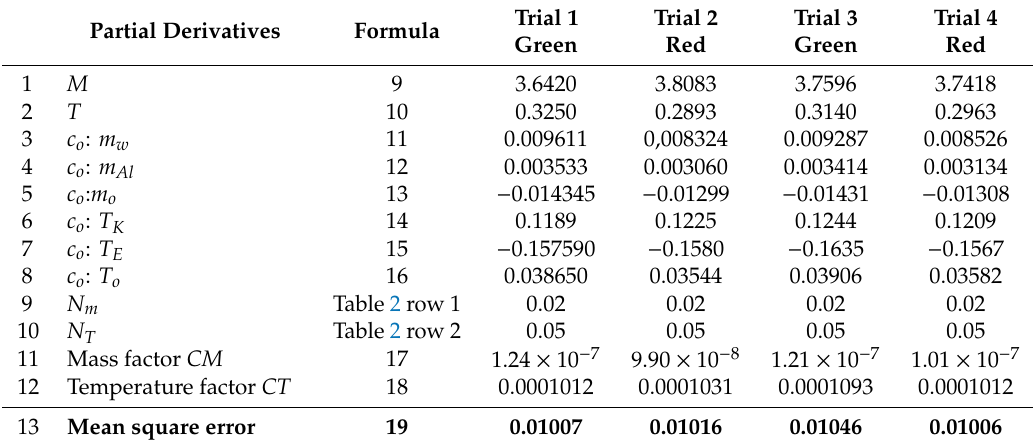
Table 5. List of partial derivative values for measurements as in Table 1 and error calculation. Ethanol as a heating